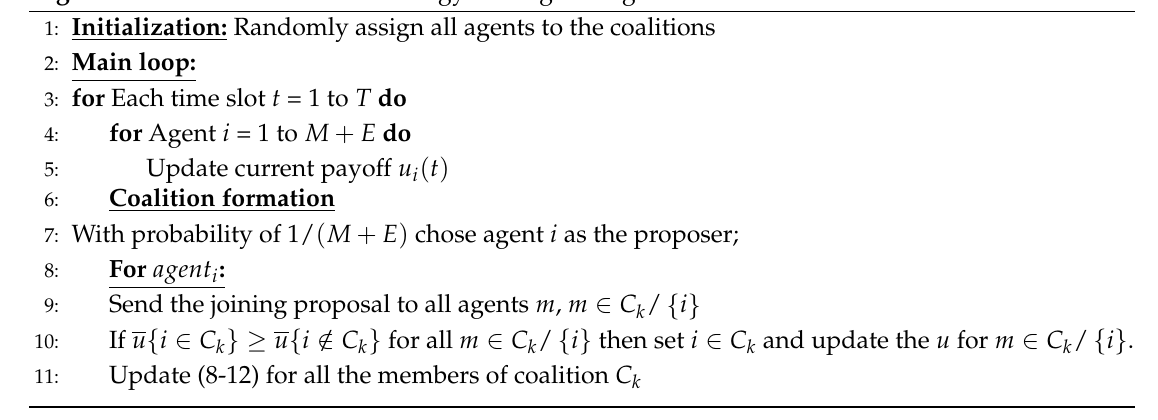
Algorithm 2 BCG formation for energy trading among MGs and